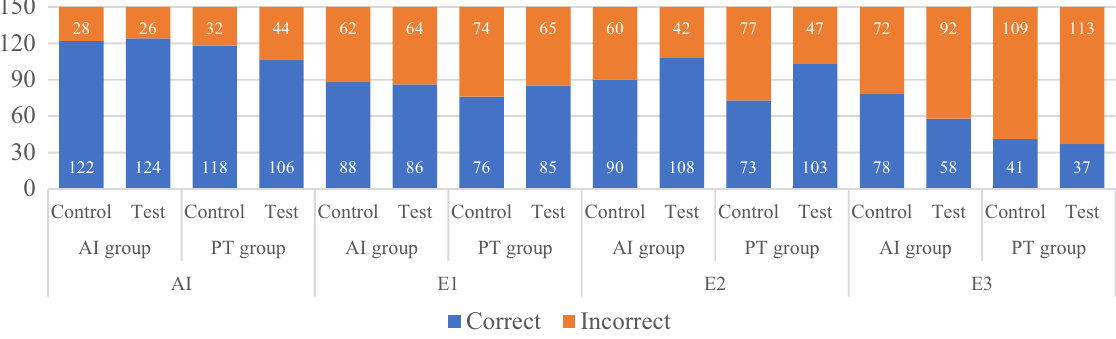
Figure 2. Correct and incorrect squats as scored by AI and evaluators (E1 = Evaluator 1, E2 = Evaluator 2, E3 = Evaluator 3). “Control” refers to the first set of 10 unassisted squat repetitions. “Test” refers to the third